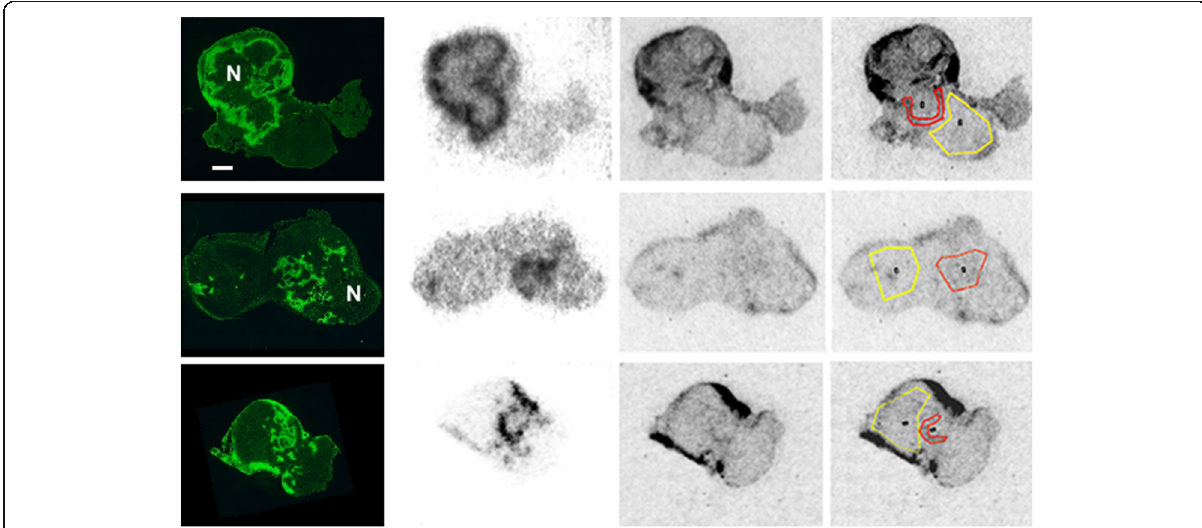
Fig. 3 Microscopic correlation between 18 F-fluoromisonidazole and 14 C-evofosfamide. Each row contains matched images from one of three individual tumors. Columns from left to right: pimonidazole, 18 F-fluoromisonidazole, 14 C-evofosfamide, and 14 C evofosfamide image with ROIs for quantitation superimposed. “ Hotspot ” outlined in red; background in yellow. Necrosis (N) was identified on adjacent sections stained by hematoxylin and eosin. Scale bar = 1